Question: Give a one-sentence summary of this figure.
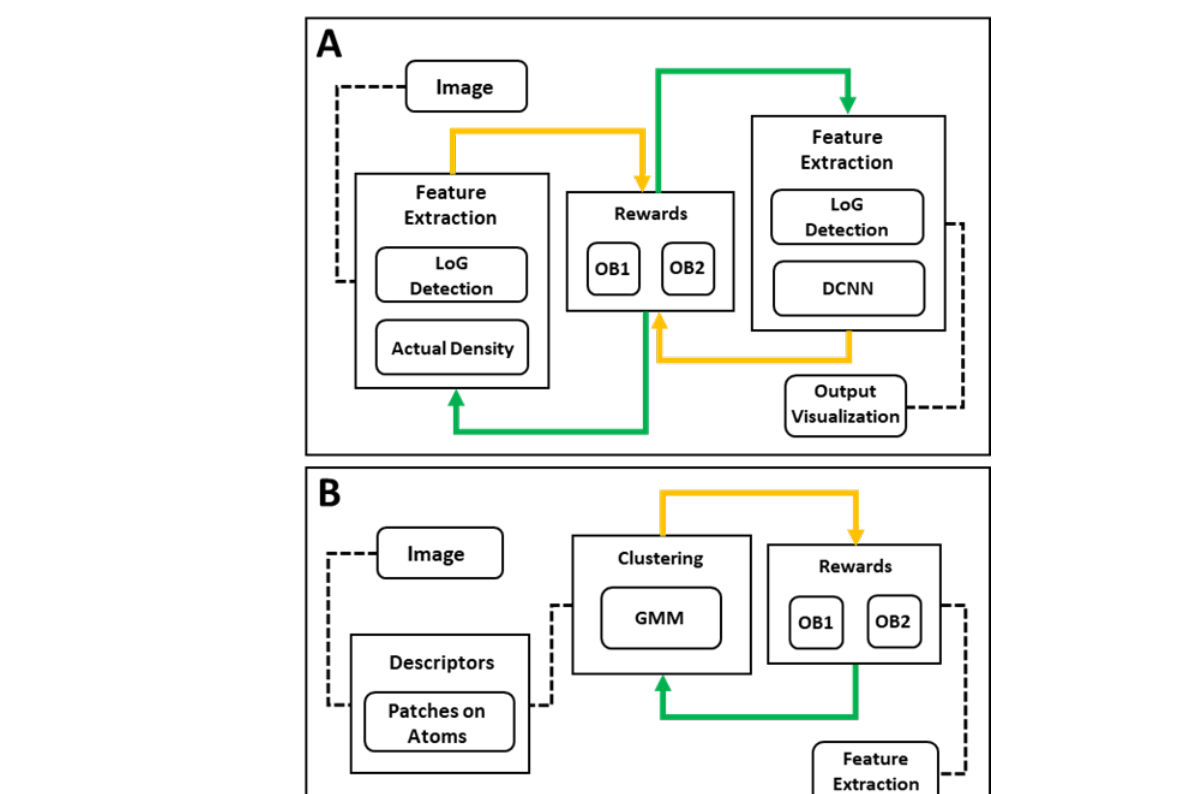
Answer: A) Workflow for reward-driven methodology in TEM images, Data preparation,  Optimization of the LoG function based on two objectives using Multi-objective Bayesian  Optimization, and Processing, B) Workflow for reward-driven methodology in TEM images, task  specified version.